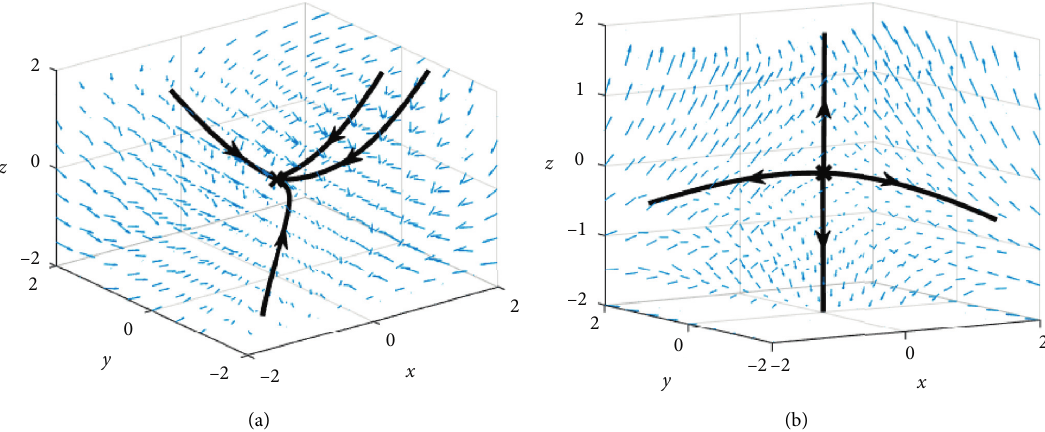
Figure 5: Stability of control parameters under the first Lyapunov exponent. (a) a � − 0.01, b � 1, c � 0, e �− 2. (b) a � 0.01, b � − 1, c � 1, e �−